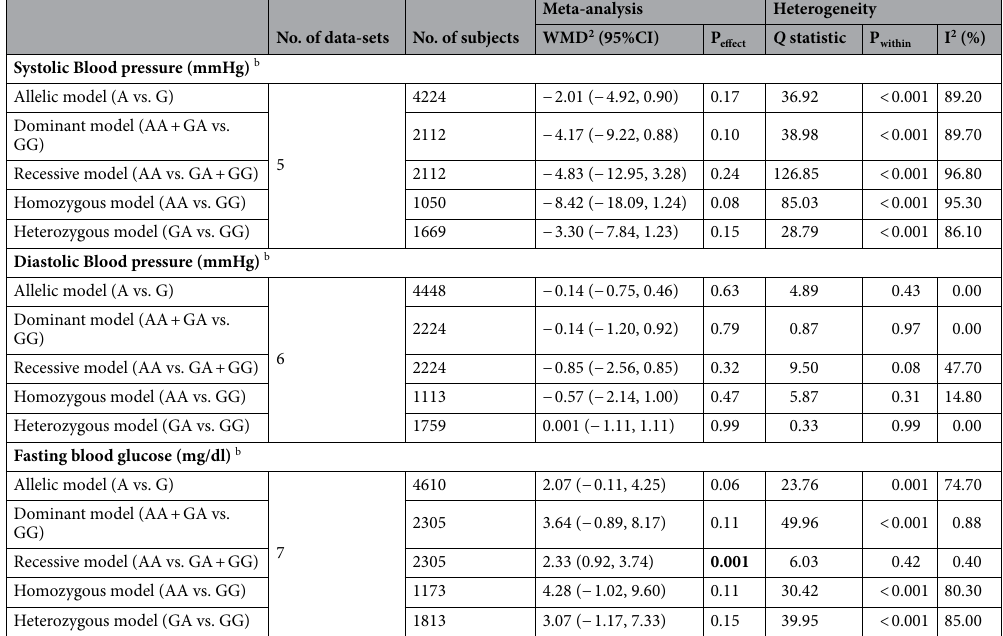
Table 4. The association between CD36 rs1761667 polymorphism and blood pressure and fasting blood glucose. All analyses were conducted using a random-effects model a . Significant values are in bold. a All analyses were done using the random-effects model. b There was no evidence of publication bias by observing the funnel plots. WMD, weighted mean difference; 95% CI, 95% confidence